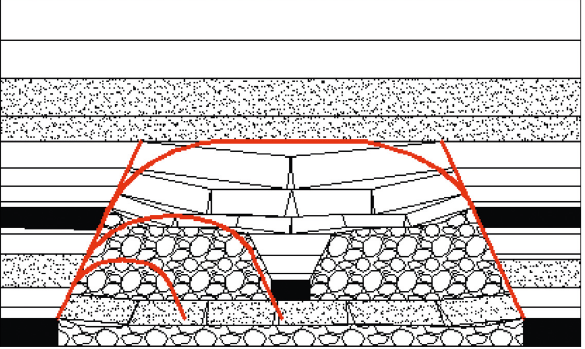
Figure 9: The relationship between upper goaf and lower goaf under the condition of thin layer